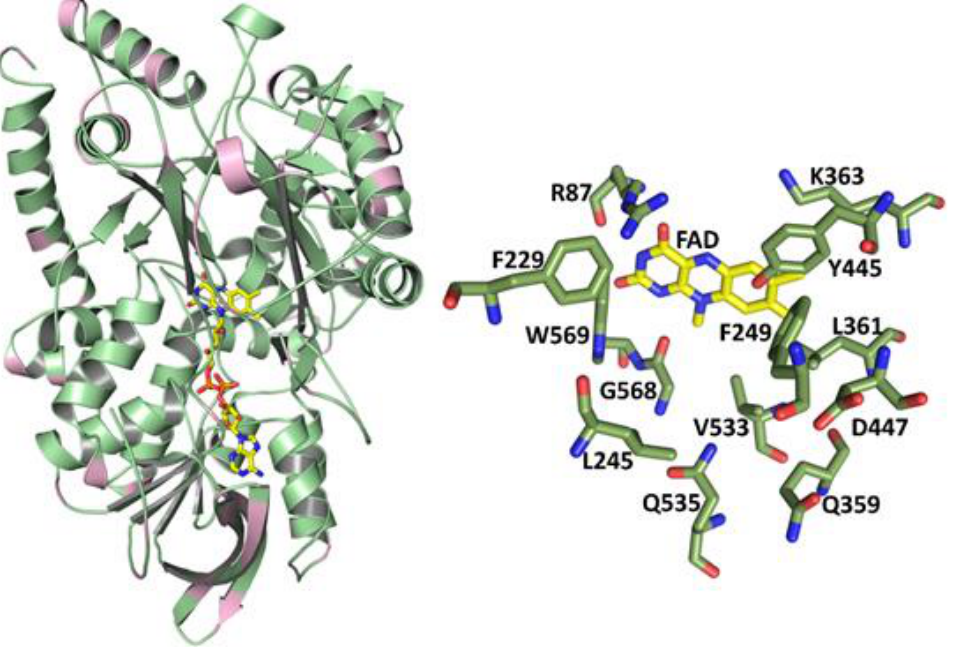
Figure 2. Structure model of P. luteoviolacea CPMOR-1 LAAO. The overall structure is shown as a cartoon on the left . The pink color indicates the regions in which differences in the amino acids between this enzyme and P. luteoviolacea CPMOR-2 LAAO were primarily located. FAD is shown with the carbons of the isoalloxazine and adenine rings yellow, nitrogens blue, oxygens red, and phosphorous orange. On the right are shown the residues in the substrate-binding area of the protein, which bind the amino acid substrates and position them for reaction with the FAD cofactor. Carbons of the amino acids are green.